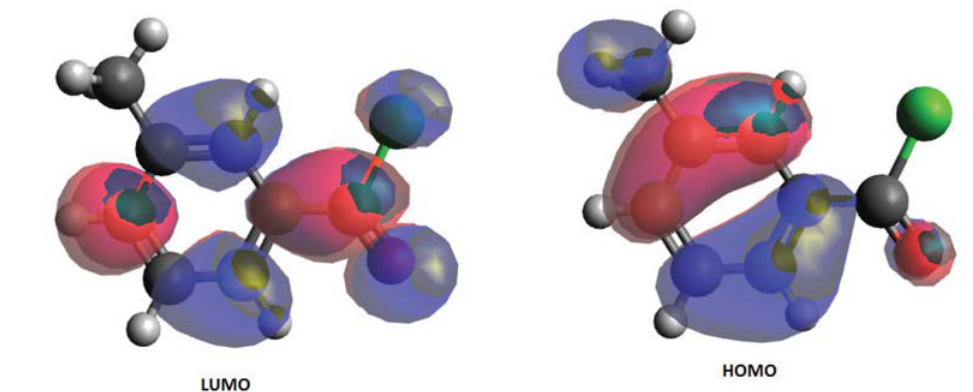
Figure 5. The atomic orbitals compositions of the Frontier molecular orbitals for m -toluolyl chloride.